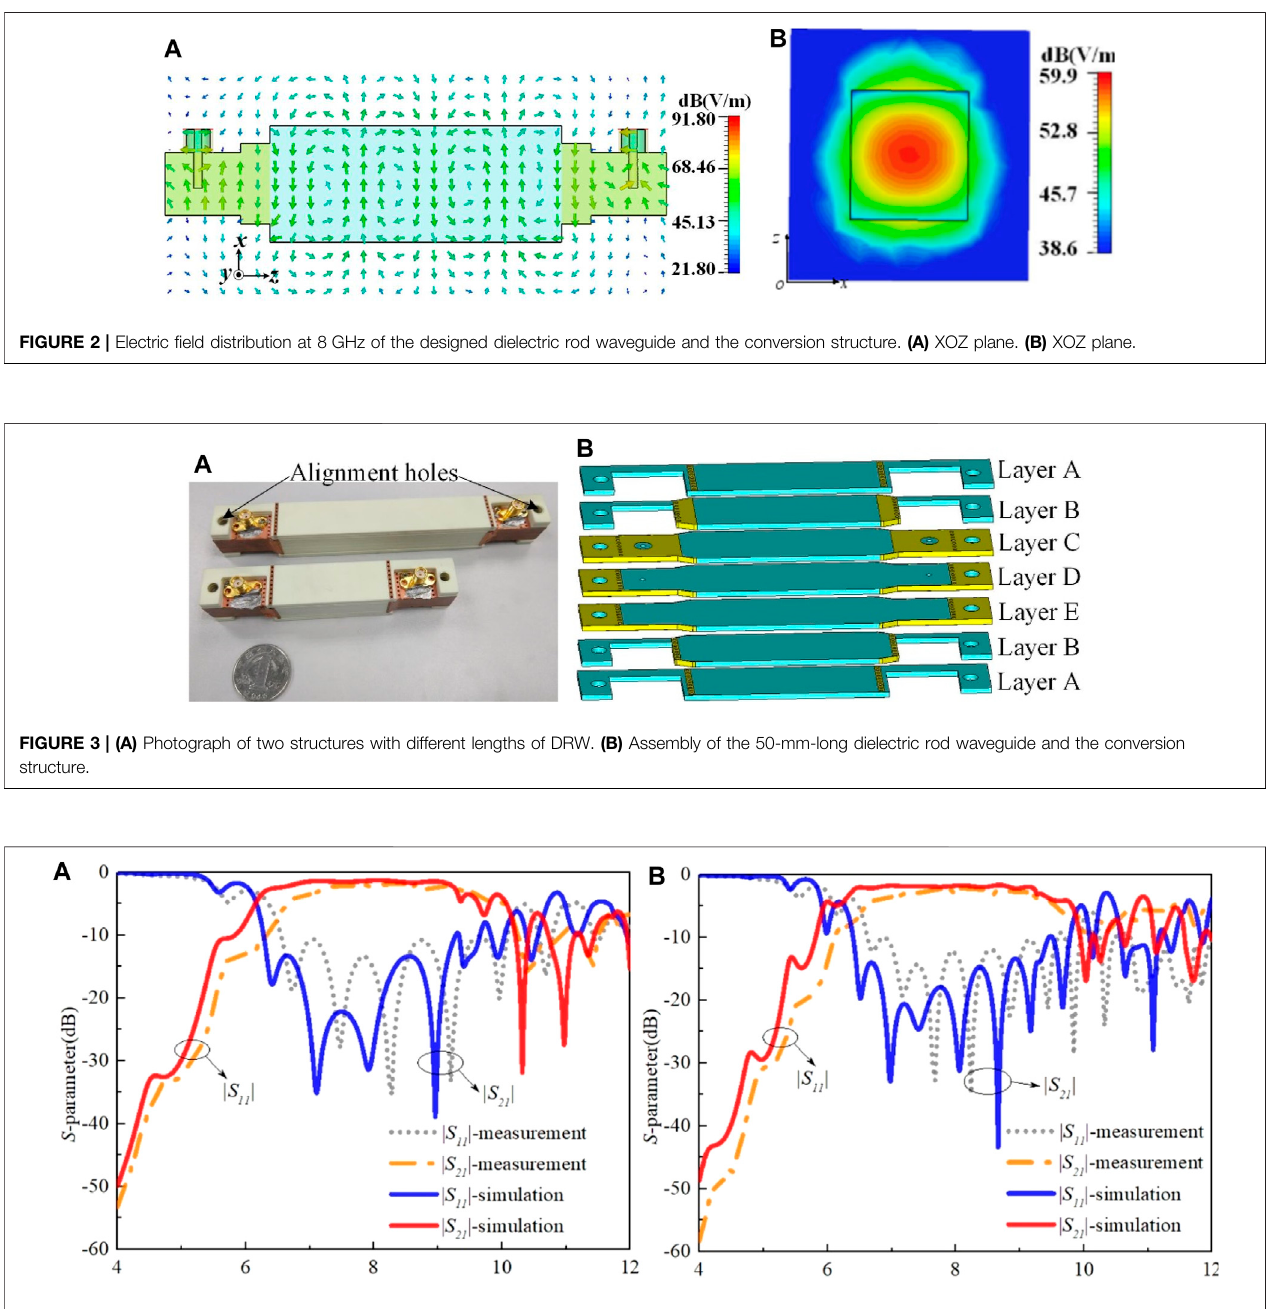
FIGURE 4 | (A) Simulation and measurement results of the structure with a length of 50 mm DRW. (B) Simulation and measurement results of the structure with a length of 100 mm DRW.